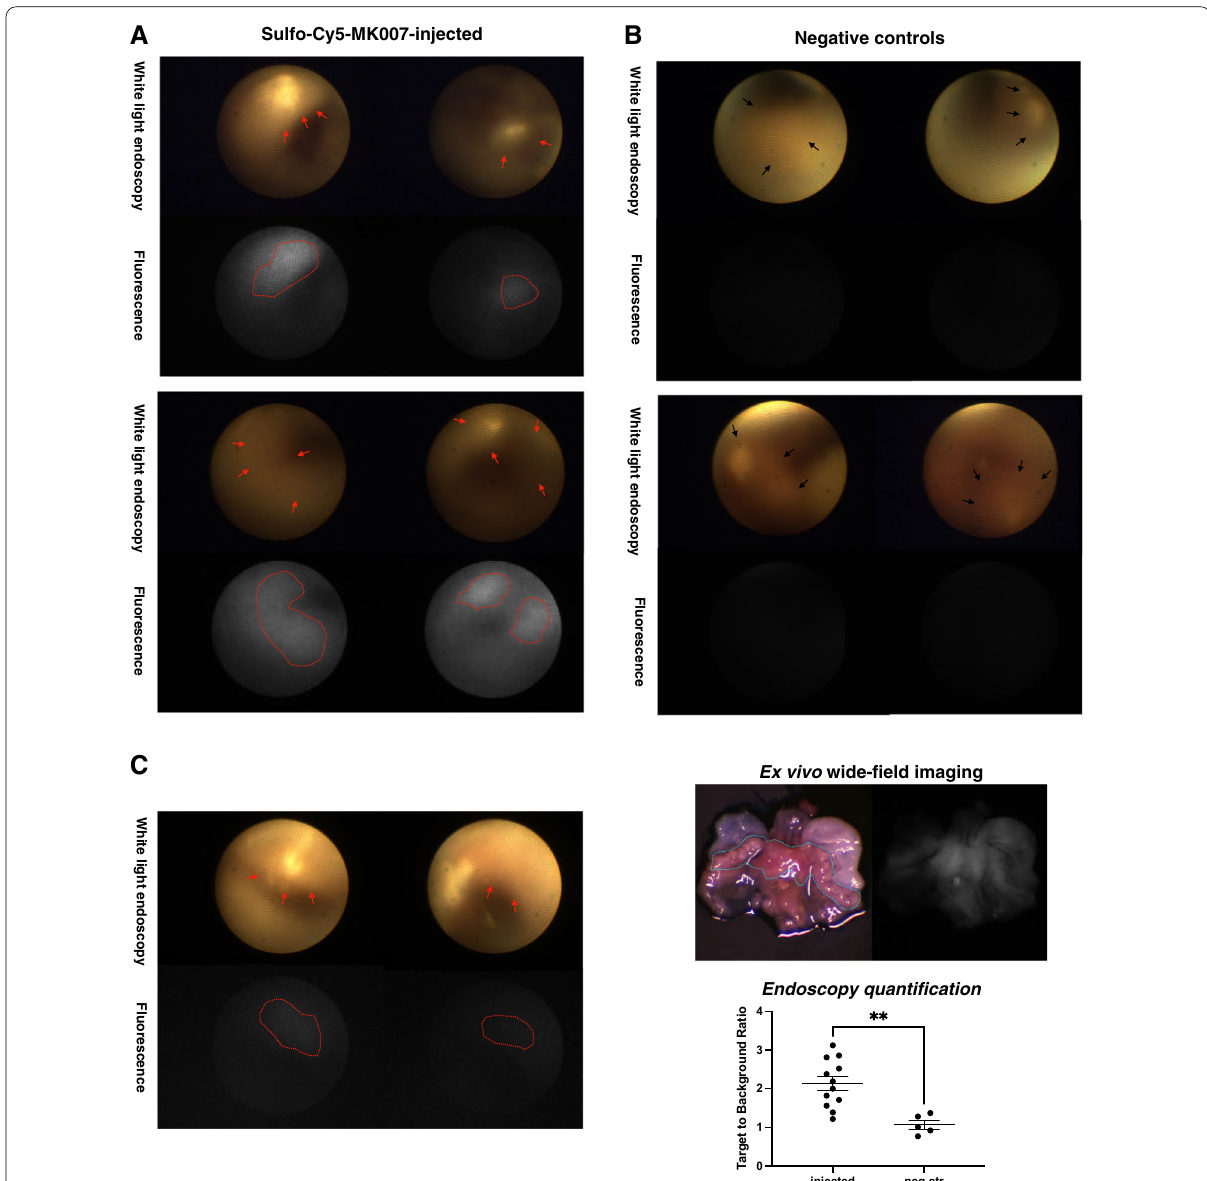
Fig. 4 Dysplastic lesions of IL1B mice detected by fluorescence endoscopy and MK007. A Representative endoscopy images of two MK007‑injected IL1B mice (60 nmol; 4 h p.i.), 14 and 12 months old (left) and two negative controls, 17 and 12 months old (right). Two endoscopy frames per each mouse are showed: visible dysplastic lesions in the color channel (red arrows) corresponded with the presence of Sulfo‑Cy5 signal (red line). No Sulfo‑Cy5 signal was detected in negative controls, despite visible lesions were found in both mice (black arrows). Fluorescence images are showed in grey scale . C Endoscopy images (left) and ex vivo wide‑field imaging (right, up) of the third injected mouse, 14 months old. The ex vivo imaging of the other two injected mice is showed in Fig. 2A. Sulfo‑Cy5 signal observed by endoscopy is indicated by the red line. A high Sulfo‑Cy5 signal in the SCJ (blue line) was further confirmed by ex vivo imaging of the whole stomach. Quantification of Sulfo‑Cy5 signal from all lesions in injected mice showed a significantly higher TBR than lesions in negative controls. Two to five dysplastic lesions were evaluated per each mouse. The signal quantification was performed as described in the Methods section. Data are represented as the TBR of each evaluated lesion and mean value SEM. ** P < 0.01 by unpaired two‑tailed T ±